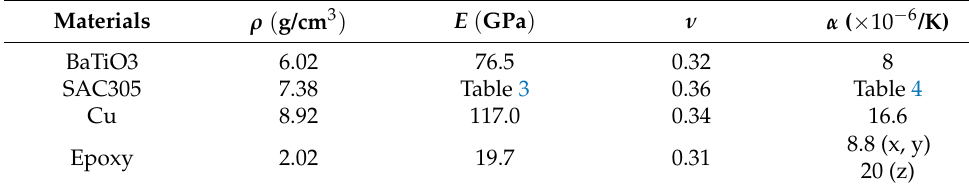
Table 2. Relevant material parameters in FEA